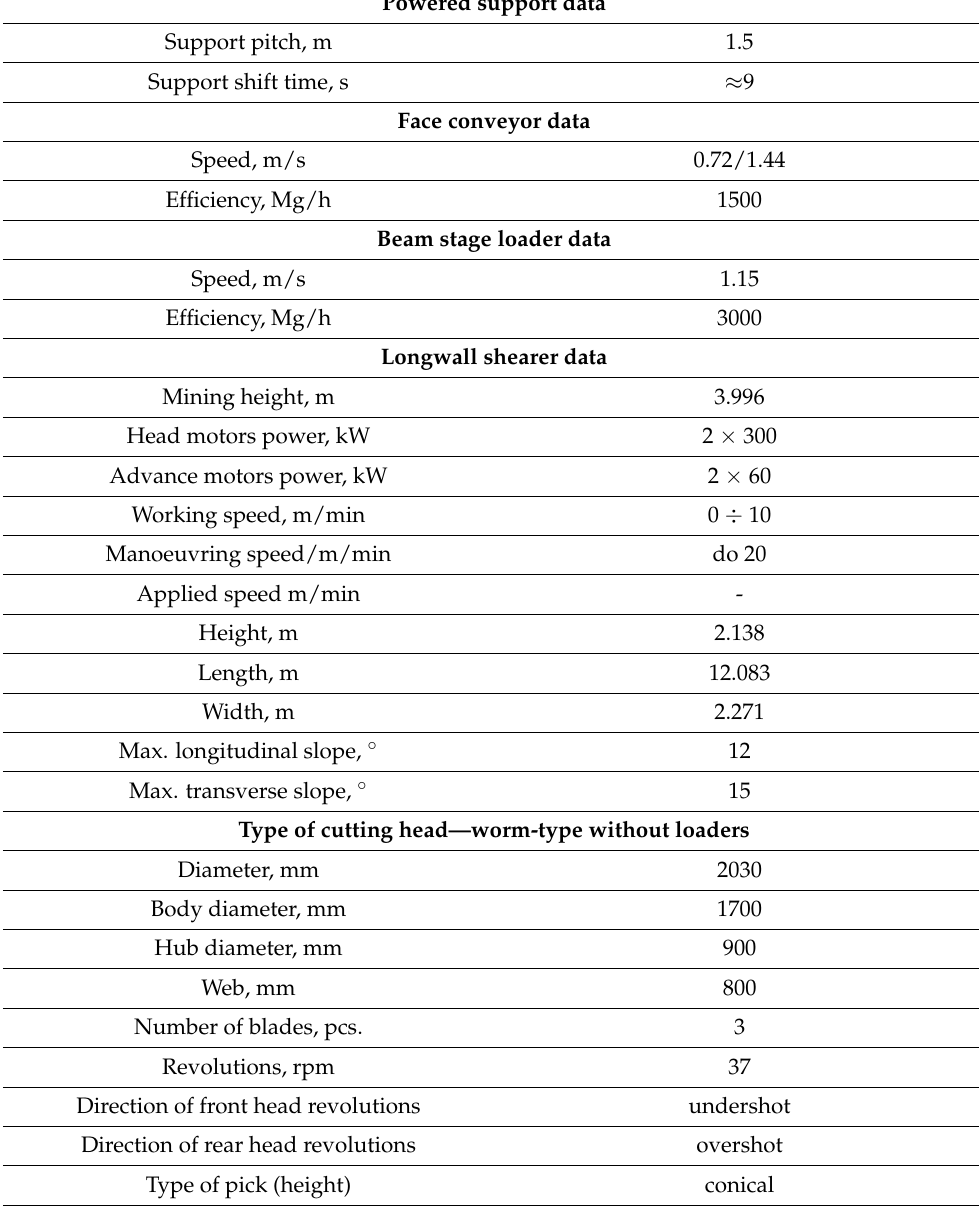
Table 2. Technical data of the longwall